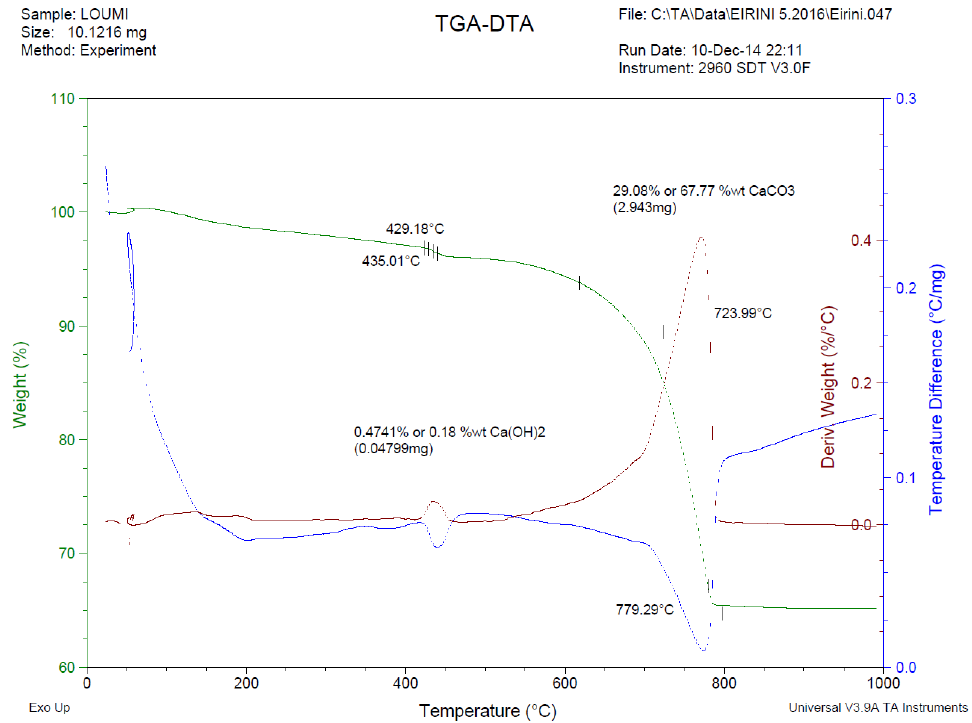
Figure 13. Differential thermal–thermogravimetric analysis (DTA-TGA) analysis of CSF and quantification of calcite content as a percentage by mass of sample.